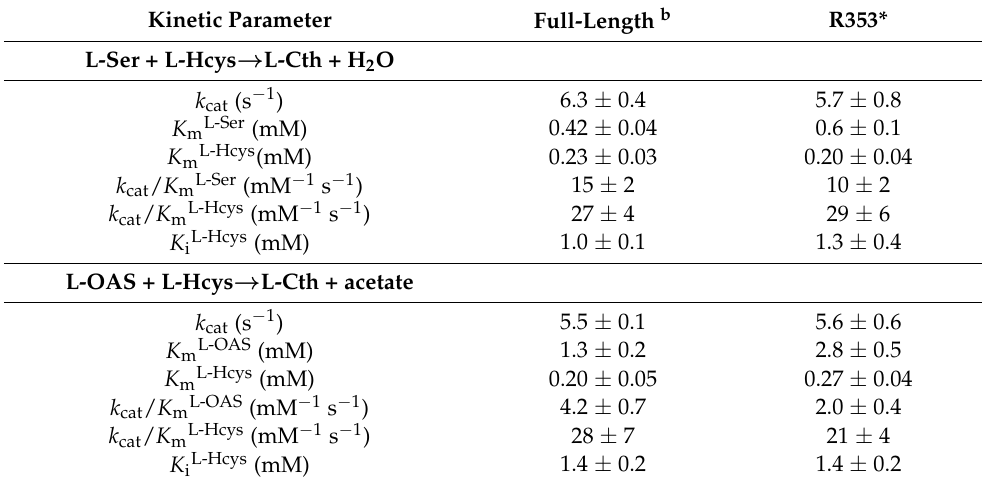
Figure 4. Canonical activity of TgCBS R353*. ( A , B ) Steady-state initial velocity kinetics for TgCBS R353* showing the dependence of the reaction on [L-Ser] and on [L-Hcys]. ( A ) The concentration of L-Ser was varied at a fixed concentration of L-Hcys. ( B ) The concentration of L-Hcys was varied at a fixed concentration of L-Ser. The fit of the entire data set to Equation (1) is represented by the lines. (C-D) Spectra of TgCBS R353* in the presence of substrates. ( C ) Absorbance spectra of 10 µM TgCBS R353* alone (solid line) and in the presence of 10 mM L-OAS (dashed line) or 10 mM L-Ser (dotted line). ( D ) CD spectra of 1 mg/mL TgCBS R353* alone (solid line) and in the presence of 10 mM L-OAS (dashed line) or 10 mM L-Ser (dotted line). Table 1. Steady-state kinetic parameters of TgCBS full-length and TgCBS R353* for canonical reactions a .